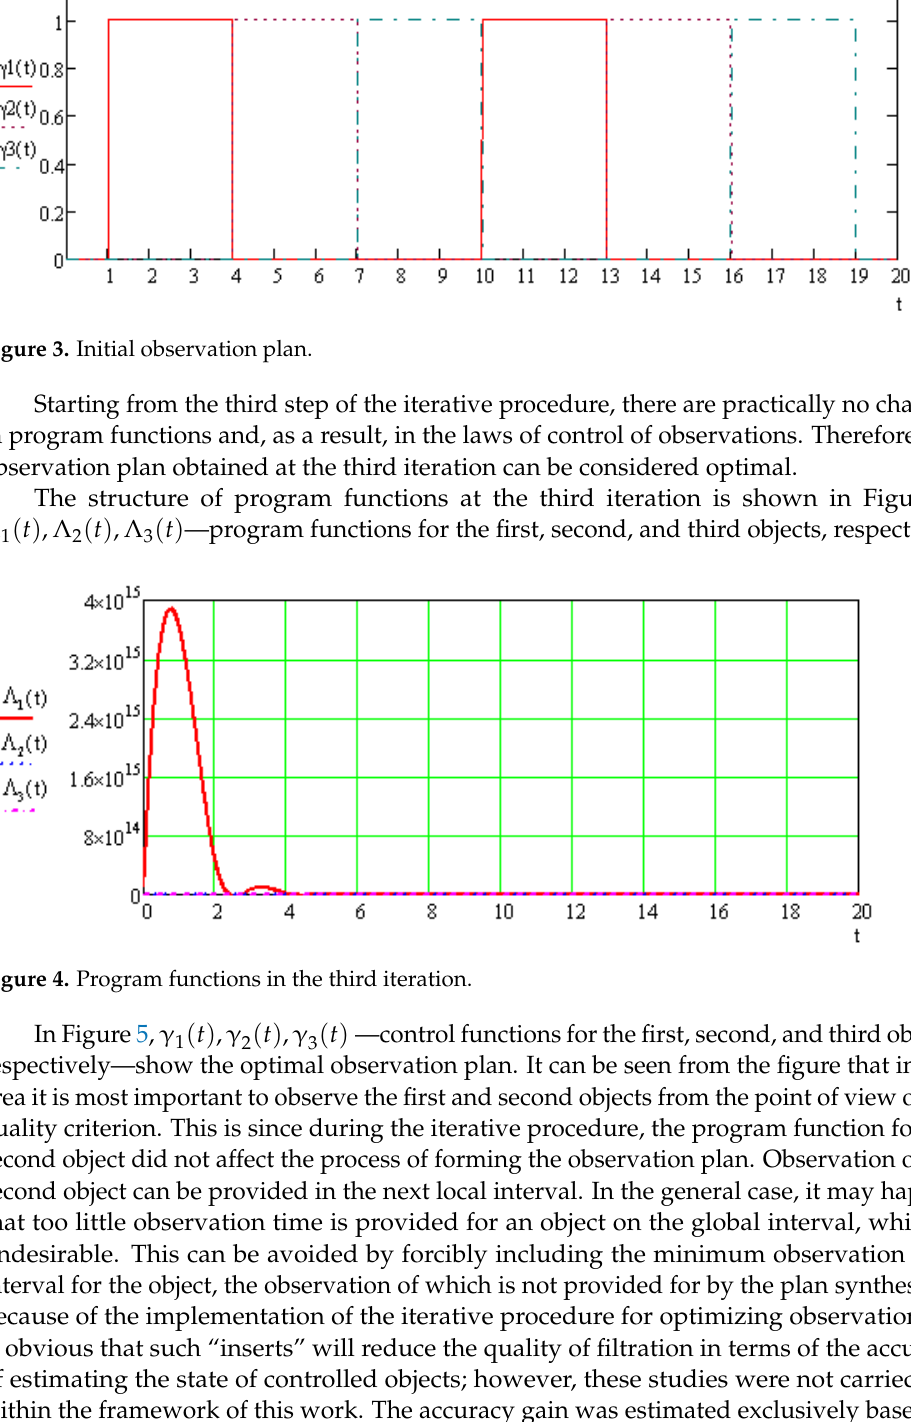
Figure 5. Optimal observation plan. The absolute value of the quality criterion for the initial plan and for the optimal plan were obtained, respectively, 0